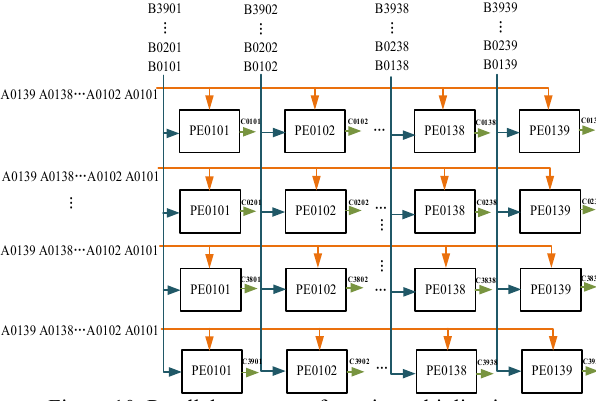
Figure 10. Parallel structure of matrix